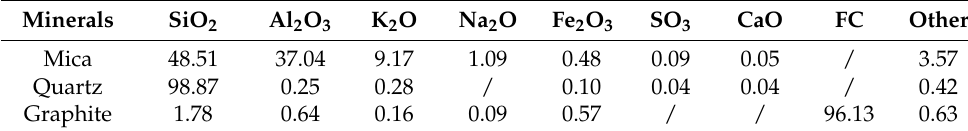
Figure 3. Particle size distribution of the test samples: ( a ) graphite; ( b ) mica; and ( c ) quartz.